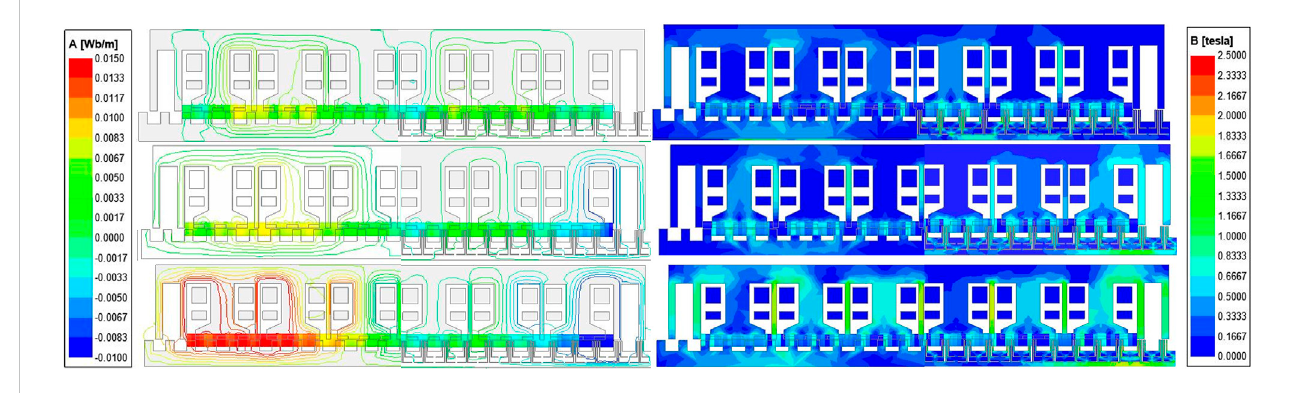
FIGURE 4 Open-circuit fl ux line distributions under different excitation levels.